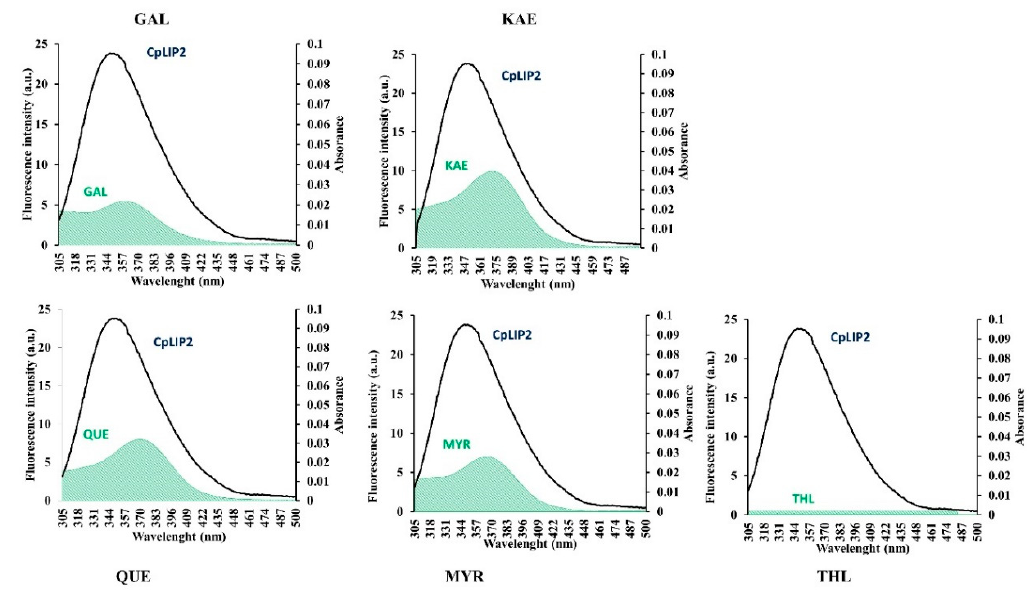
Figure 7. The overlap of the fluorescence emission spectrum of CpLIP2 lipase (black) with the absorption spectrum (green area) of GAL (galangin), KAE (kaempferol); QUE (quercetin); MYR (myricetin); THL (orlisat) used at 2.5 µM, T = 308 K, and pH 7.0. λ ex = 285 nm, λ em = 305–500 nm.